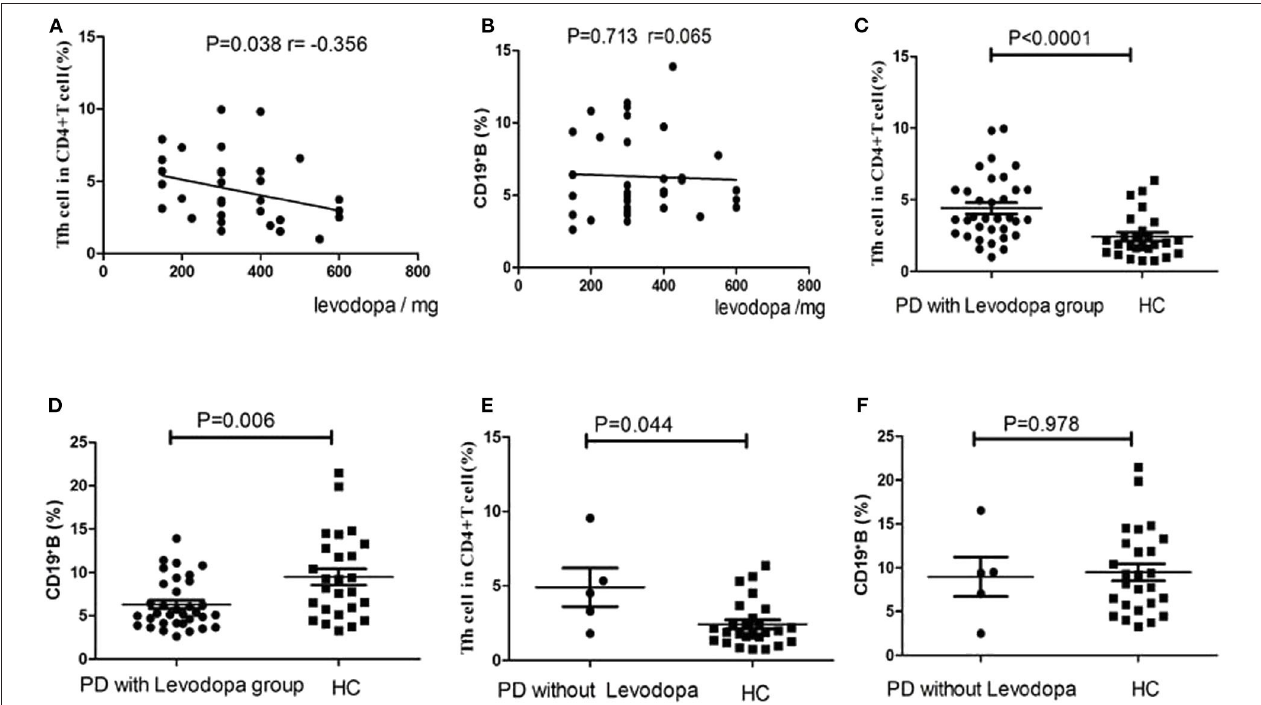
FIGURE 6 | Correlation analysis of the levodopa dosage in PD patients with the cTfh cells and B cells. (A) The correlation analysis between levodopa dosage and the levels of Tfh cells ( P = 0.038), (B) The correlation analysis between levodopa dosage and the levels of B cells ( P = 0.713). (C) The comparison of the cTfh cells between PD with levodopa group and HCs ( P < 0.0001). (D) The comparison of the B cells between PD with levodopa group and HCs ( P = 0.006). (E) The comparison of the cTfh cells between PD without levodopa group and HCs ( P = 0.044). (F) The comparison of the B cells between PD without levodopa group and HCs ( P =